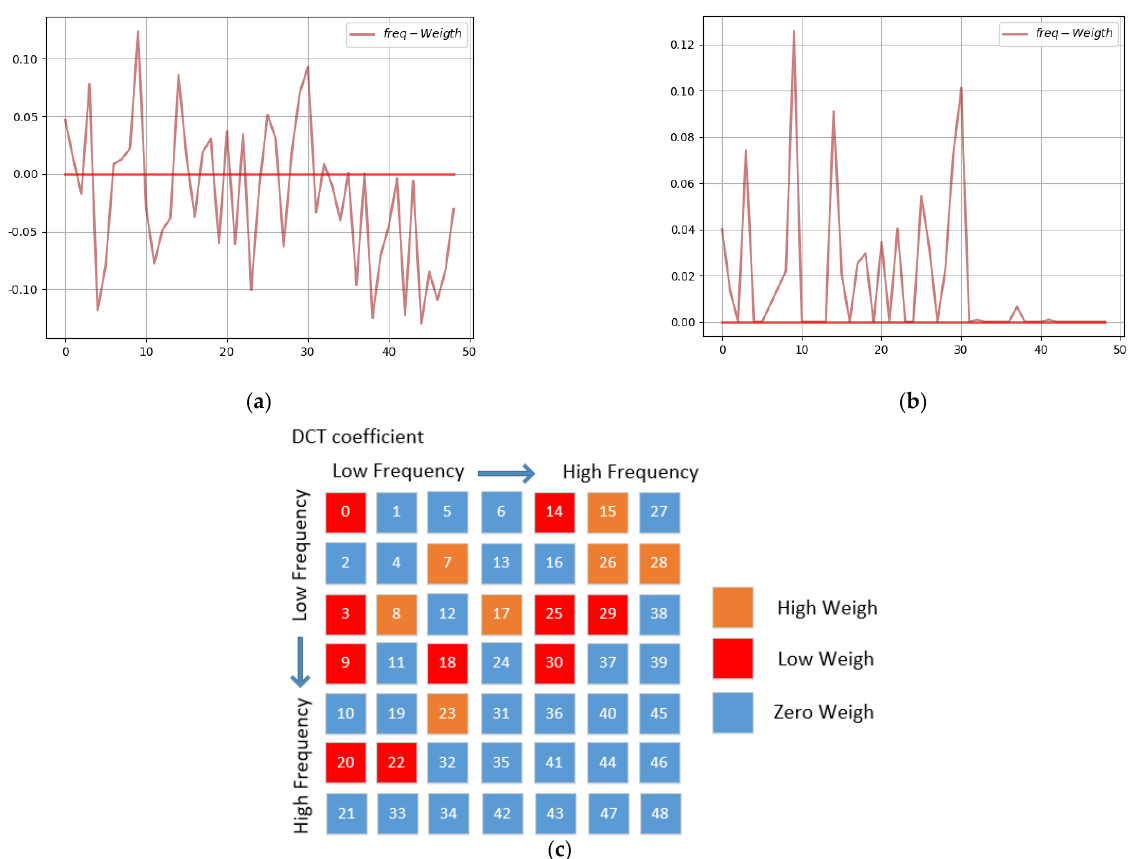
Figure 6. Results of the third AFcaNet weight of the encoder. ( a ) Linear Layer Weight; ( b ) After ReLU Weight; ( c ) The ( b ) mapping in 2D-DCT